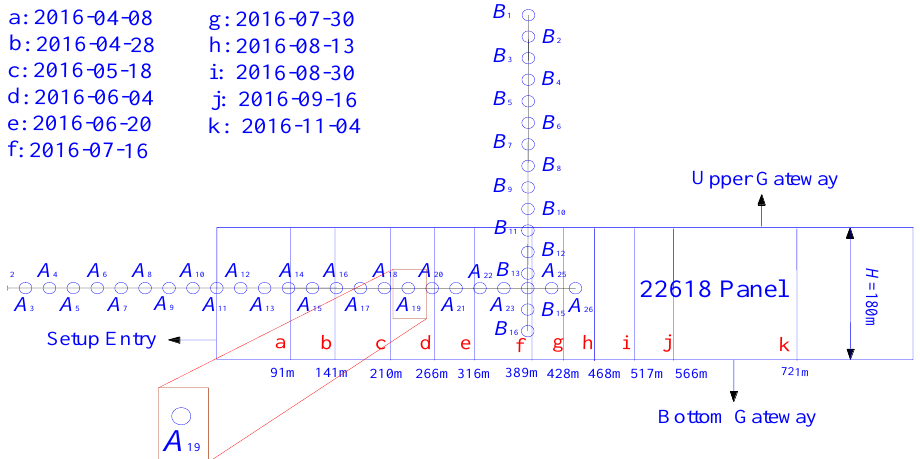
Figure 6. Layout of surface subsidence observation points.